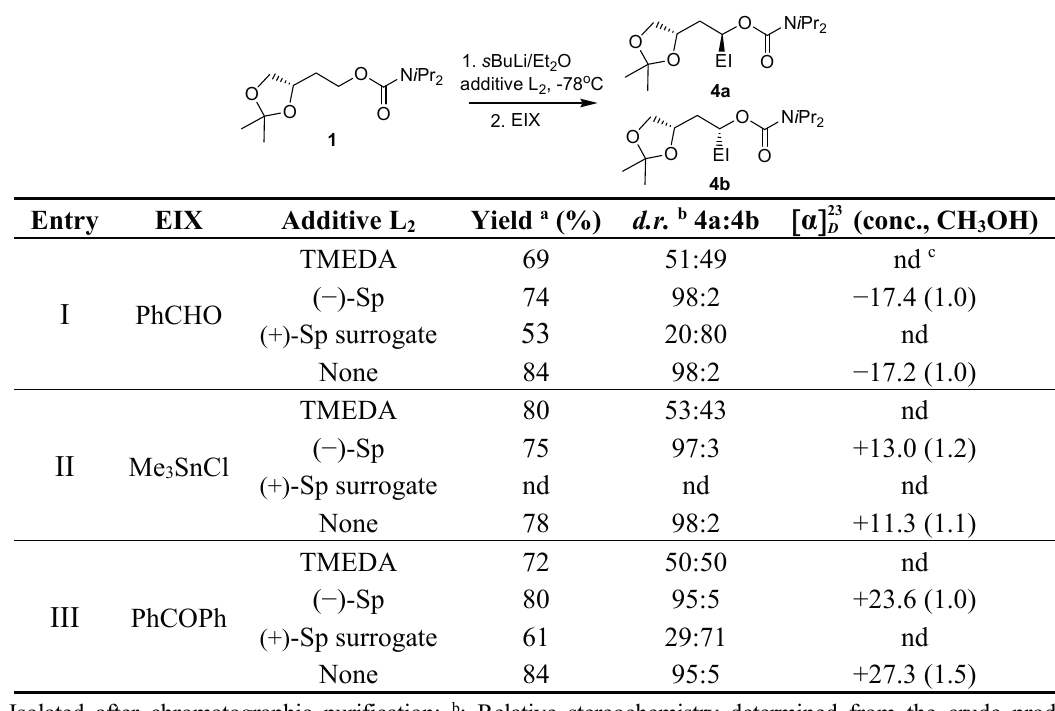
Table 1. The chelation-directed asymmetric lithiation of carbamate 1